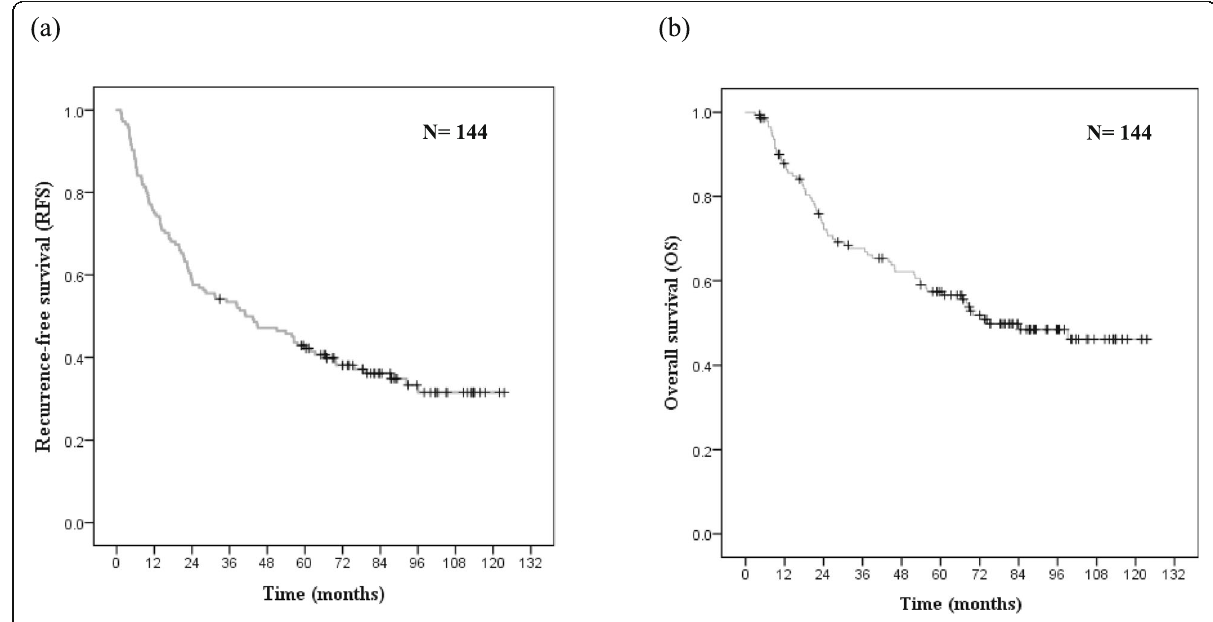
Fig. 2 Kaplan-Meier analysis showing recurrence-free survival ( a ) and overall survival ( b ) of the entire study